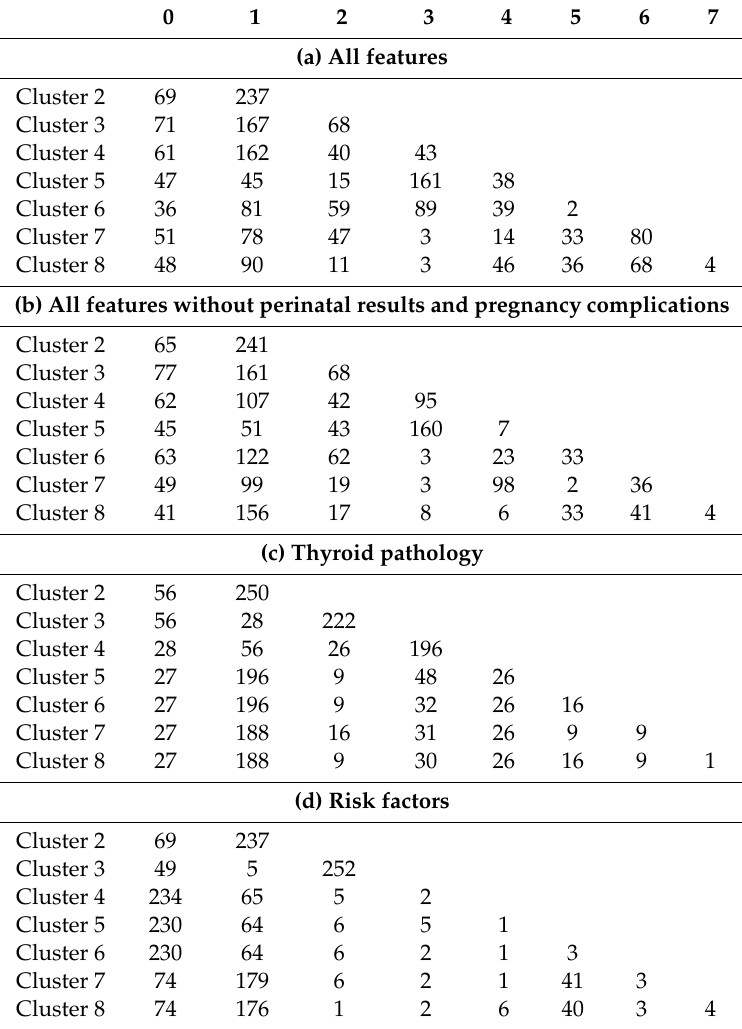
Table 2. Number of women in the first trimester pregnancy